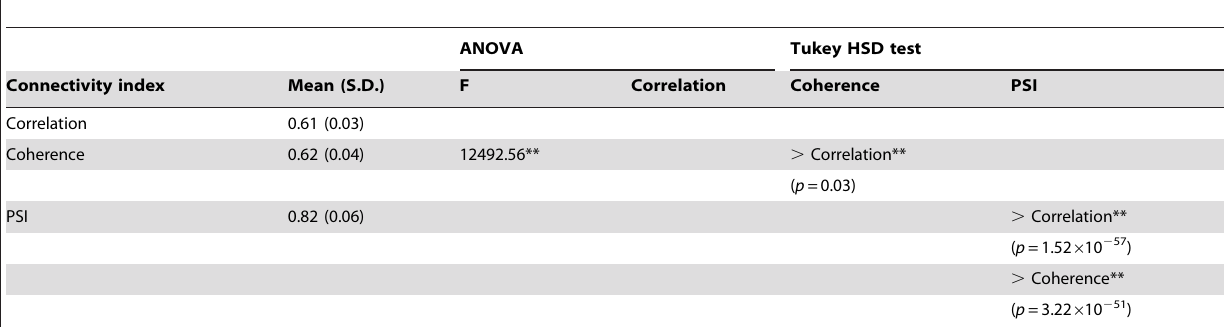
Table 9. Comparison of Classification Accuracy by Different Connectivity